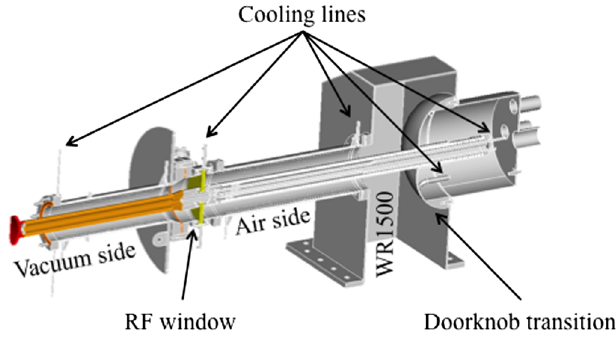
FIG. 2. Fundamental power coupler for the BNL SRF gun.